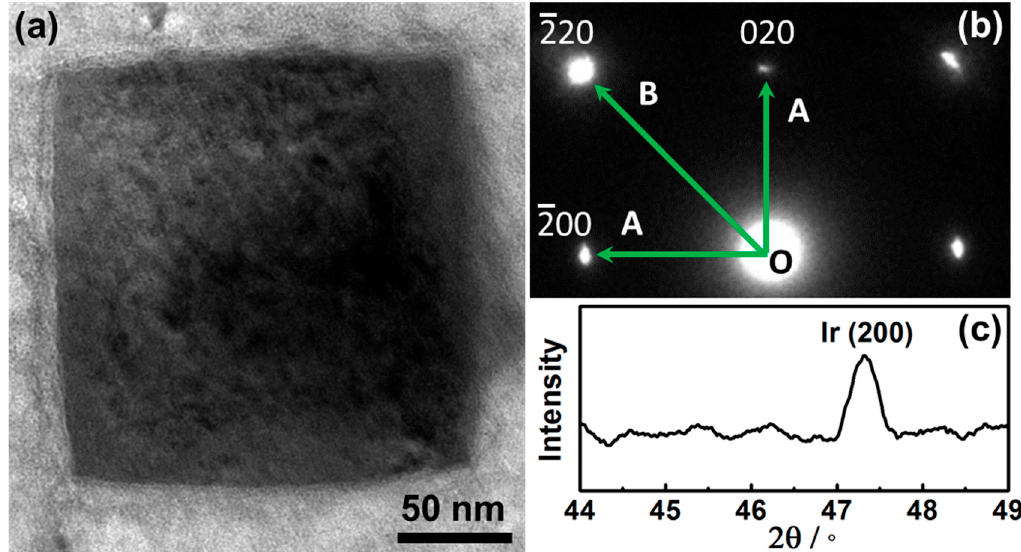
Figure 2. ( a ) TEM of a typical Ir nanoparticle. ( b ) SAED of the nanoparticle. ( c ) XRD of the nanoparticles as synthesized on Cu foil.